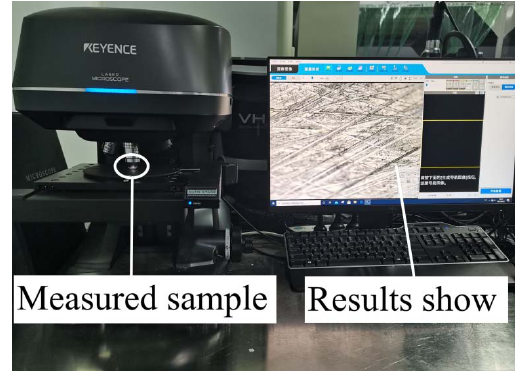
Figure 10. Laser confocal microscope.